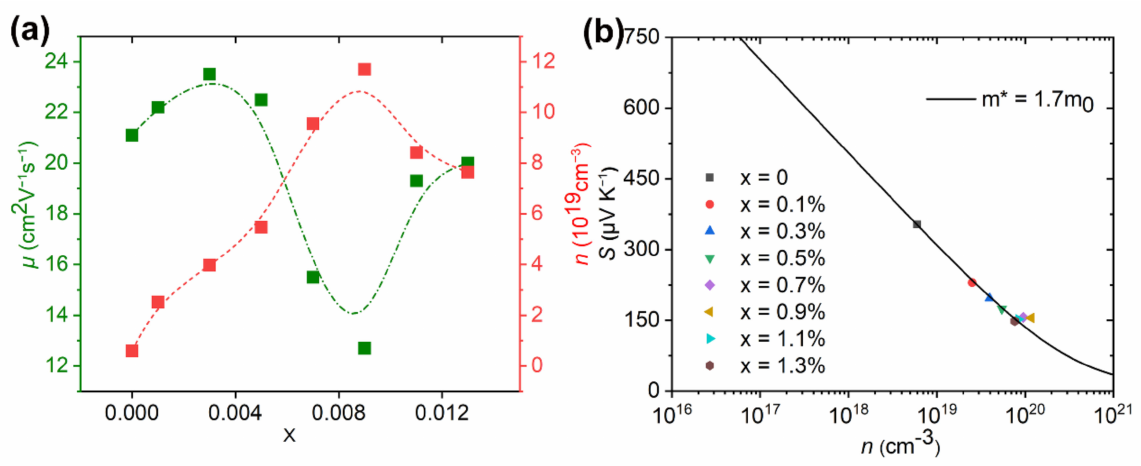
Figure 4. ( a ) Change of carrier concentration ( n ) and carrier mobility ( µ ) with doping content x, ( b ) Change of Seebeck coefficient ( S ) with carrier concentration ( n ). The line in ( b ) was calculated by the SPB model discussed in detail elsewhere [28,33]. m* is the electron effective mass at the Fermi